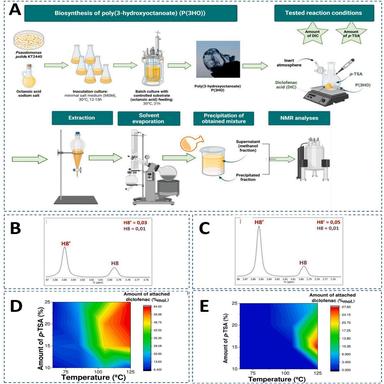
(A) A scheme of the experimental pathway leading to the preparation of Dic-oligo(3HAs). The processing included biosynthesis of the bacterial polymer P (3HO), testing the reaction parameters, post-synthetic treatment of the resulting reaction mixtures, as well as NMR analyses. Created with (http://BioRender.com); (B) 1 H NMR of the Dic-oligo(3HAs) reaction mixture; (C) an identical sample after addition of four drops of diclofenac solution (25 g⋅L− 1 ). As H8 are the protons of the –CH2– group of DIC adjace